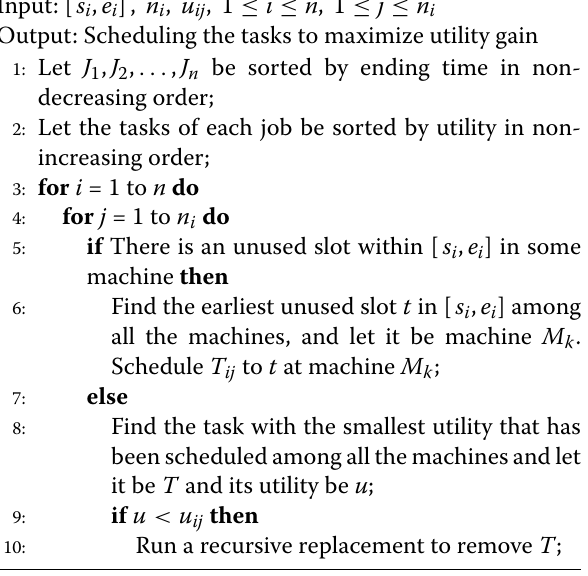
Algorithm 4 EDF-Multi